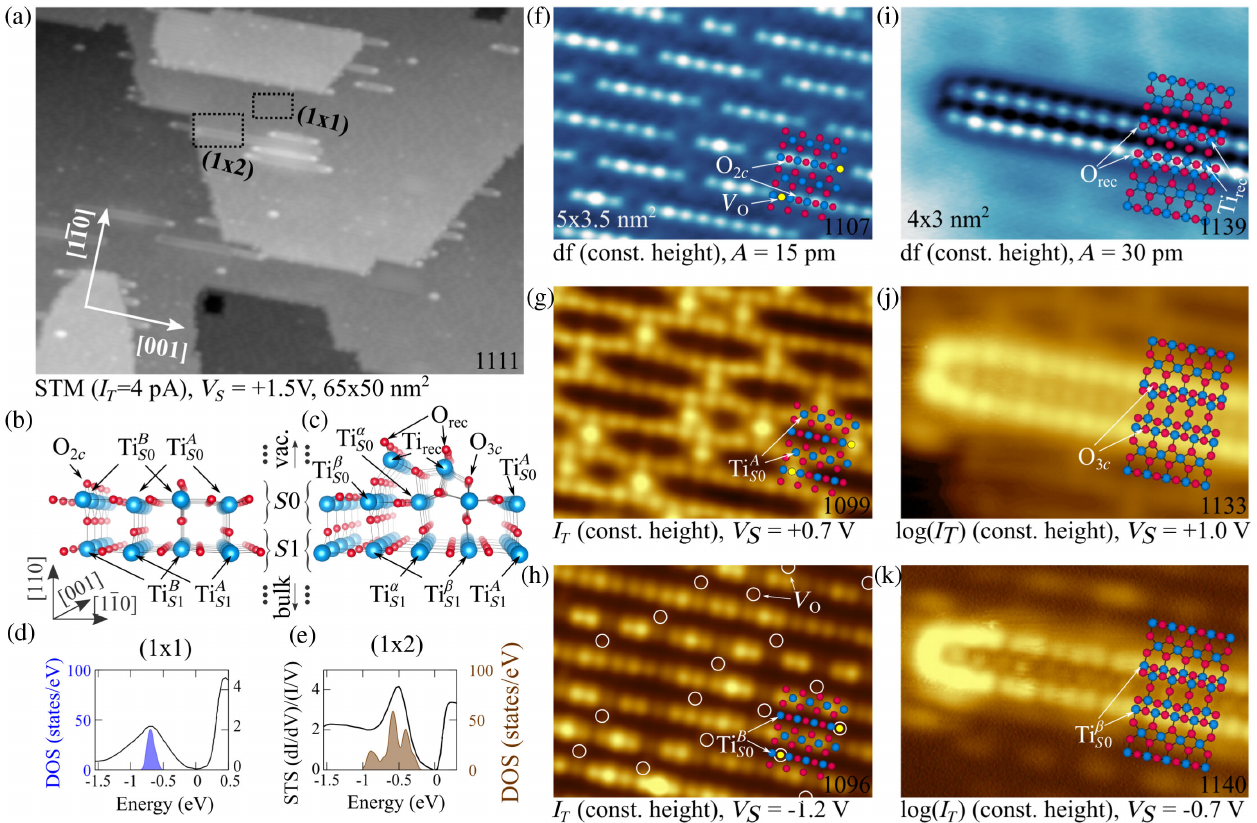
FIG. 1. The ( 1 × 1 ) and ( 1 × 2 ) surface phases of TiO 2 ð 110 Þ . (a) Large-area STM image of a reduced rutile (110) single crystal. Unreconstructed ( 1 × 1 ) regions with single oxygen vacancies V appear together with reconstructed ( 1 × 2 ) Ti 2 O 3 stripes. (b,c) O Structural models of the ( 1 × 1 ) and ( 1 × 2 ) phases, respectively. (d,e) STS spectra (line) taken above ( 1 × 1 ) and ( 1 × 2 ), together with calculated polaronic gap states (filled area), shifted upwards by ≈ 0 . 25 eV to align the center of mass of the Ti 3 þ (polaronic) peaks with the experiment (in this way, the DFT peak positions are also in better agreement with the calculated vertical excitation energy E [46]). EL (f) – (k) High-resolution images of the ( 1 × 1 ) and ( 1 × 2 ) regions marked in panel (a), overlaid with the respective structural models. AFM images (i,f) show the highest O atoms (O 2 c and O ) on the surface, and STM images show the empty (g,j) and filled (h,k) rec